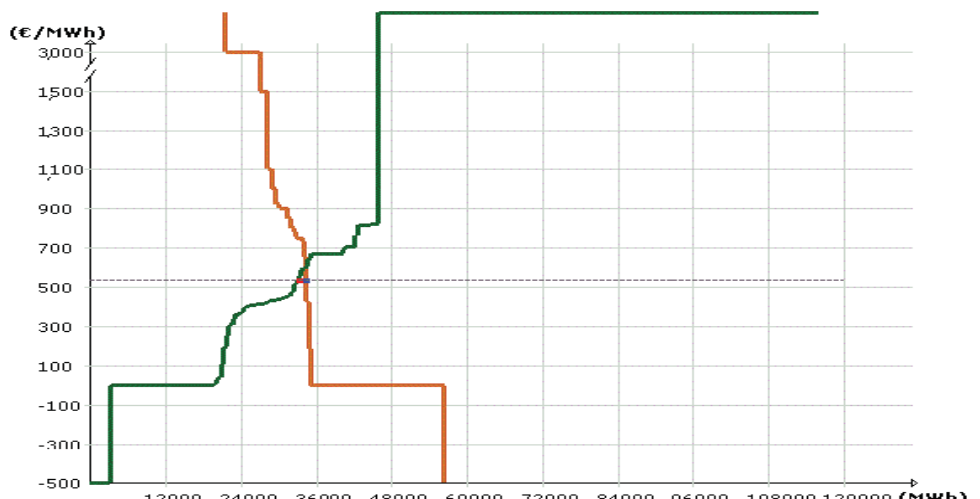
Figure 2 . Market clearing outcomes in the DAM on the 22 September 2020; 12 a.m. The green line represents the aggregate electricity supply, the orange line the aggregate electricity demand.